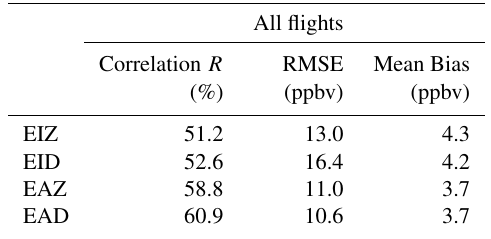
Table 1. Correlation coefficient, root mean square error and mean bias between δ CO proxy (z(t)) and δ CO cold for the different meteo- rological settings (EAZ, EAD, EIZ, EID). Values are averaged on the results from all the eight